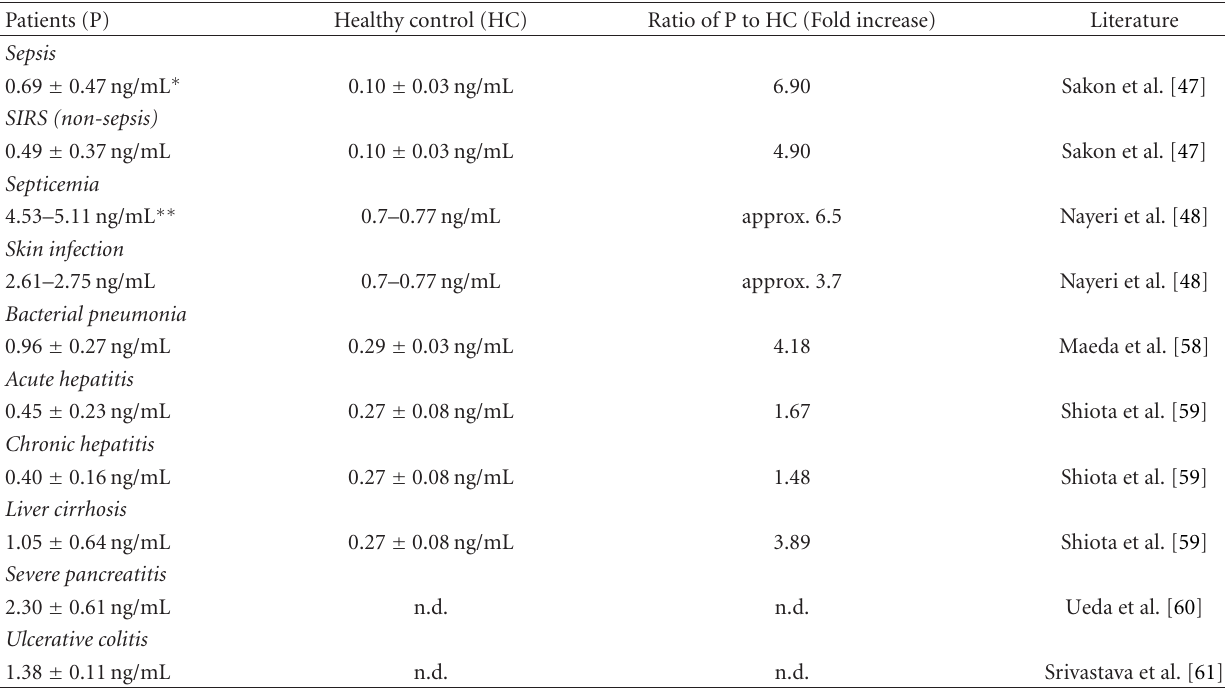
Table 2: Increases in blood HGF levels in patients during various